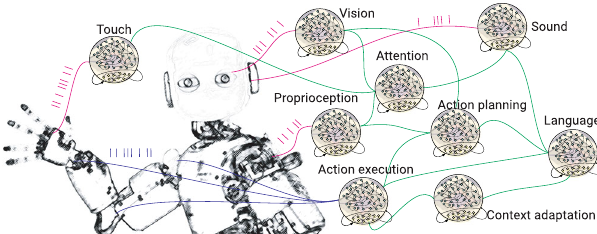
Fig. 1 Robots with end-to-end neuromorphic intelligence. Some non exhaustive examples of perception (magenta), intelligent behaviour (green) up to action execution (blue) that would all be implemented by means of dedicated Spiking Neural Network (SNN) hardware technology.